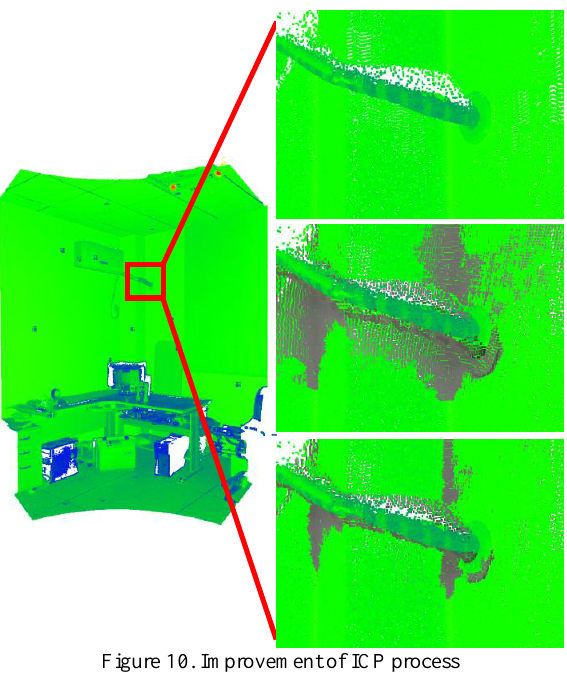
Figure 10. Improvement of ICP process